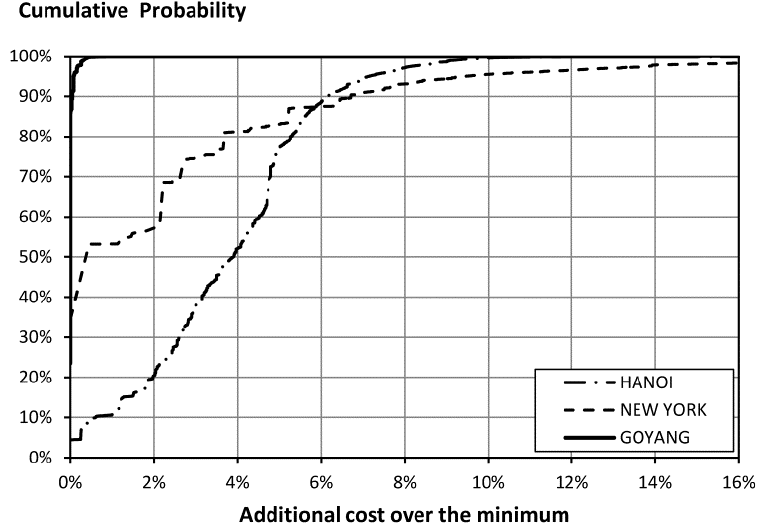
Figure 4. Histogram of solutions for all of the simulations.